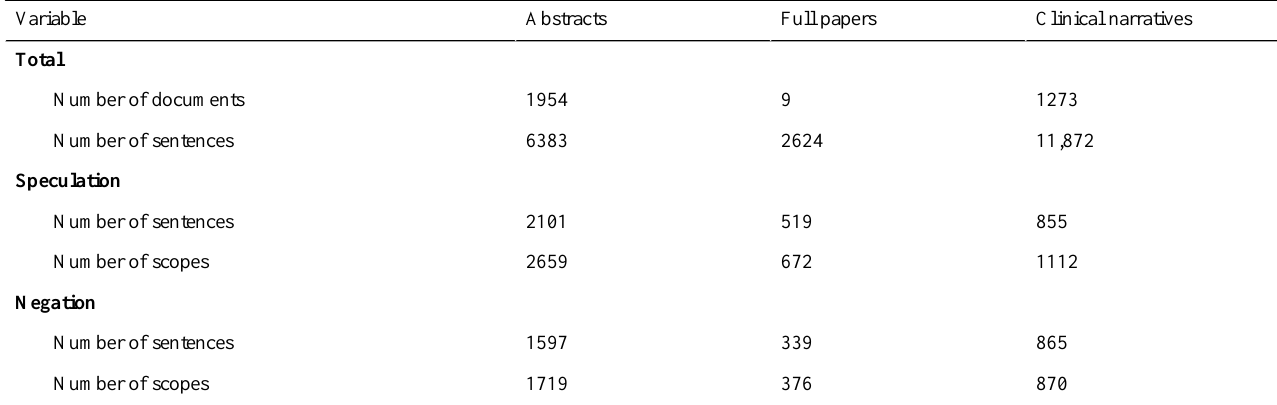
Table 6. BioScope corpus